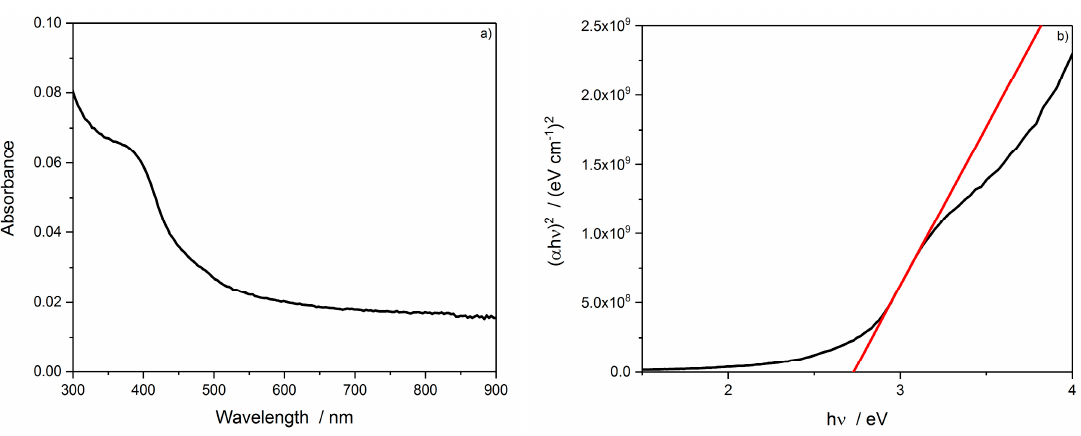
Figure 6. ( a ) UV-Vis absorbance spectra of plasma-coated bismuth oxide borosilicate glass; ( b ) Plot of ( α h ν ) 2 vs. ( h ν ) to determine the direct band gap; N = 4.